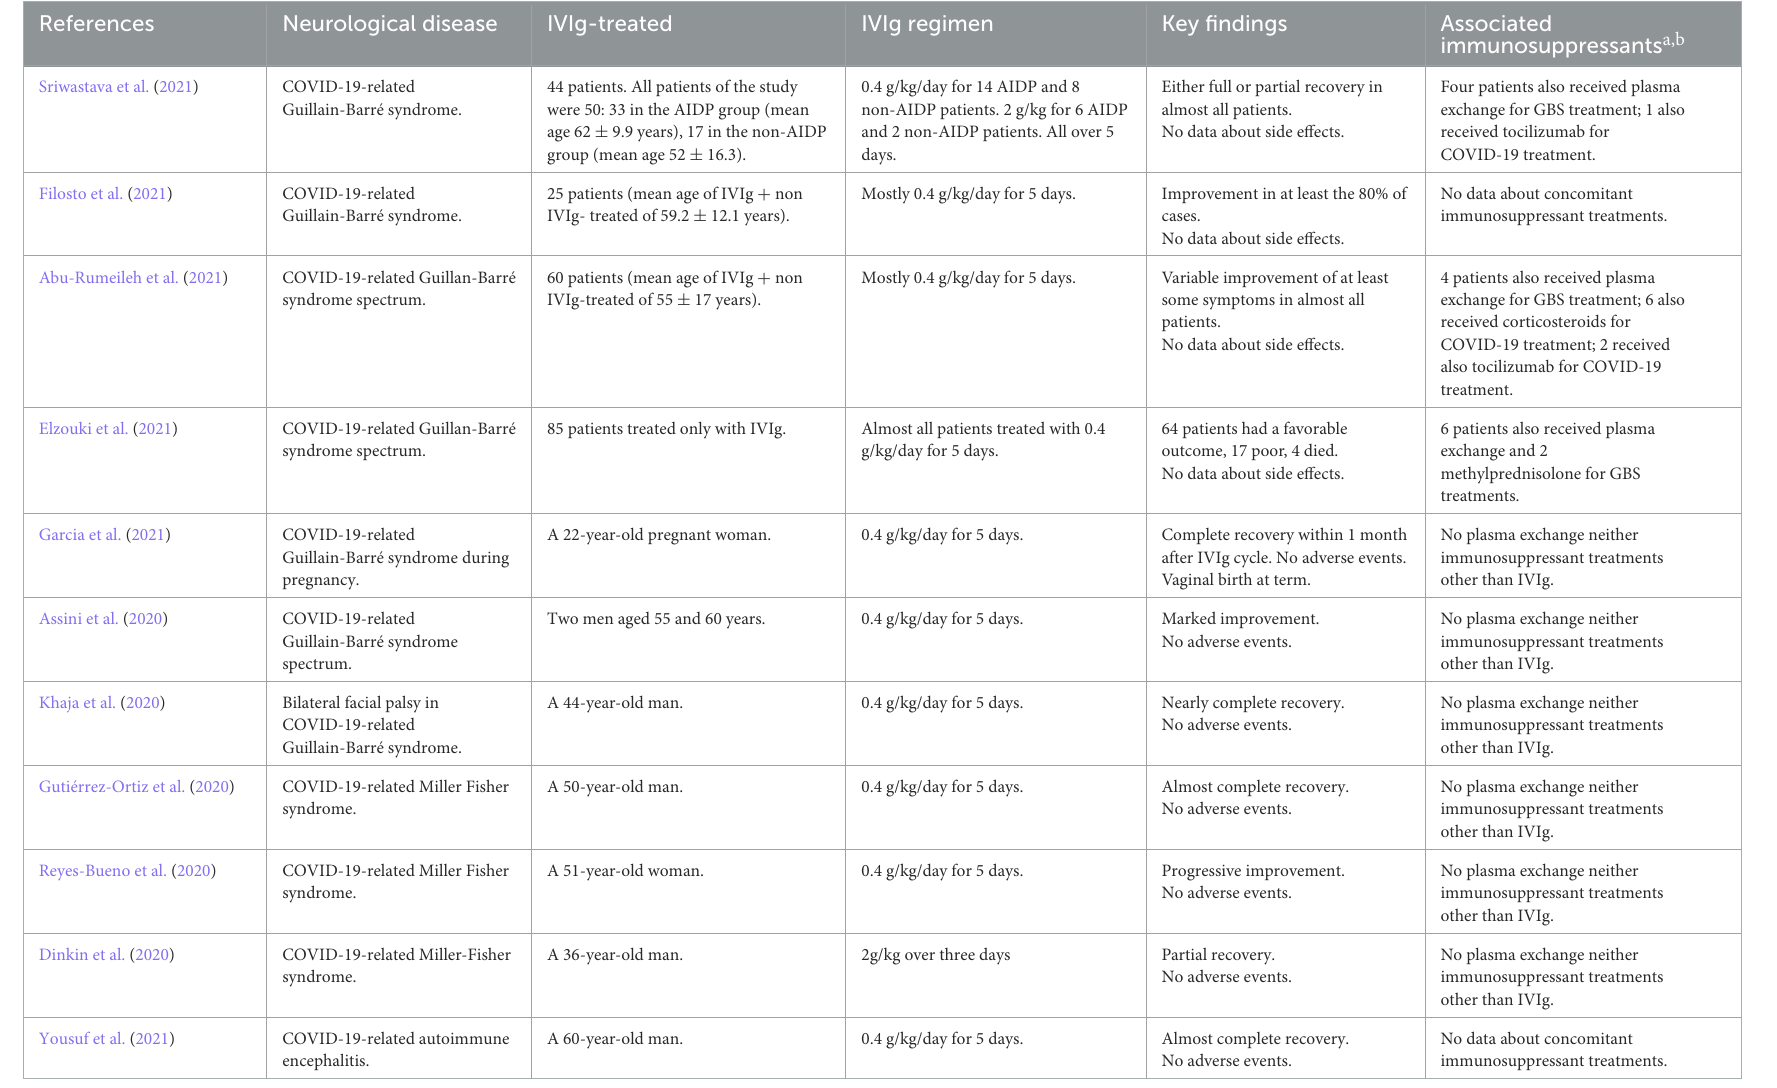
TABLE 1 Summary of studies related to IVIg treatment in COVID-19 patients presenting neurological